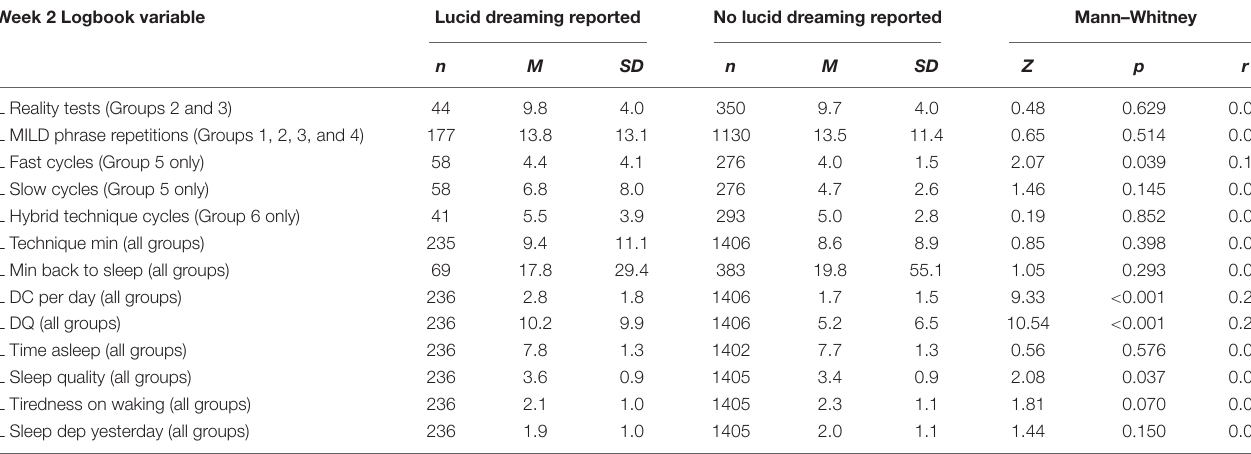
TABLE 6 | Mann–Whitney tests for differences in week 2 logbook variables between nights when practice of lucid dream induction techniques was and was not followed by lucid dreaming. Week 2 Logbook variable Lucid dreaming reported No lucid dreaming reported